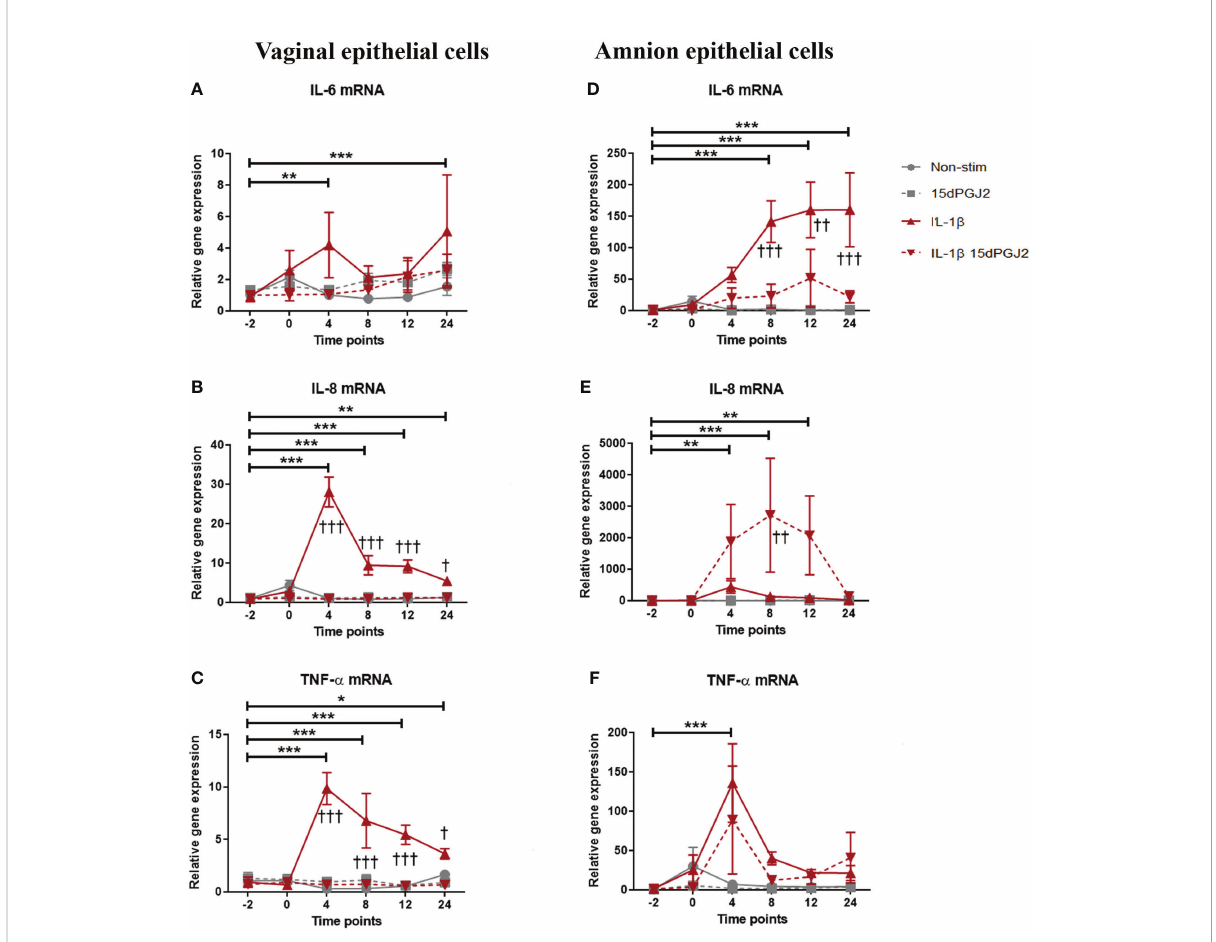
FIGURE 7 Effect of 15dPGJ2 on IL-6, IL-8 and TNF- a mRNA in vaginal and amnion epithelial cells. VEC and AECs were pre-incubated with 32 m M of 15dPGJ2 for 2 hours then stimulated with 1ng/ml of IL-1 b . Cells were harvested, and total RNA was quanti fi ed after -2, 0, 4, 8, 12 and 24 hours. Quantitative PCR was performed looking at IL-6, IL-8 and TNF- a mRNA level. Fold change took into account the reference gene b actin IL-1 b stimulation increased IL-6 mRNA expression in VEC at 4 ( ** ) and 24 (***) hours but no statistically signi fi cant inhibition was achieved with 15dPGJ2 pre-incubation (A) . IL-8 mRNA expression increased with IL-1 b stimulation and this effect was inhibited by 15dPGJ2 at 4, 8, 12 (***, ††† ) and 24 (**, † ) hours (B) . TNF- a mRNA also increased with IL-1 b stimulation and this effect was inhibited by 15dPGJ2 at 4, 8, 12 (***, ††† ) and 24 (*, † ) hours (C) . In amniocytes, IL-1 b stimulation signi fi cantly increased IL-6 expression in which this effect was inhibited at 8 (***, ††† ), 12 (***, †† ) and 24 (***, ††† ) hours (D) . Pre-incubation of 15dPGJ2 before IL-1 b stimulation increased IL-8 mRNA compared to IL-1 b alone ( †† ) at 8 hours (E) . TNF- a mRNA expression increased at 4 hours with IL-1 b stimulation (***) but the inhibition by 15dPGJ2 did not reach statistical signi fi cance (F) . n = 3. * p < 0.05, ** p < 0.01, *** p < 0.001 = effect of IL-1 b compared to -2 non-stimulated time point. † p < 0.05, †† p < 0.01, ††† p < 0.001 = effect of IL-1 b 15dPGJ2 compared to IL-1 b treatment alone. Data are presented as mean ±